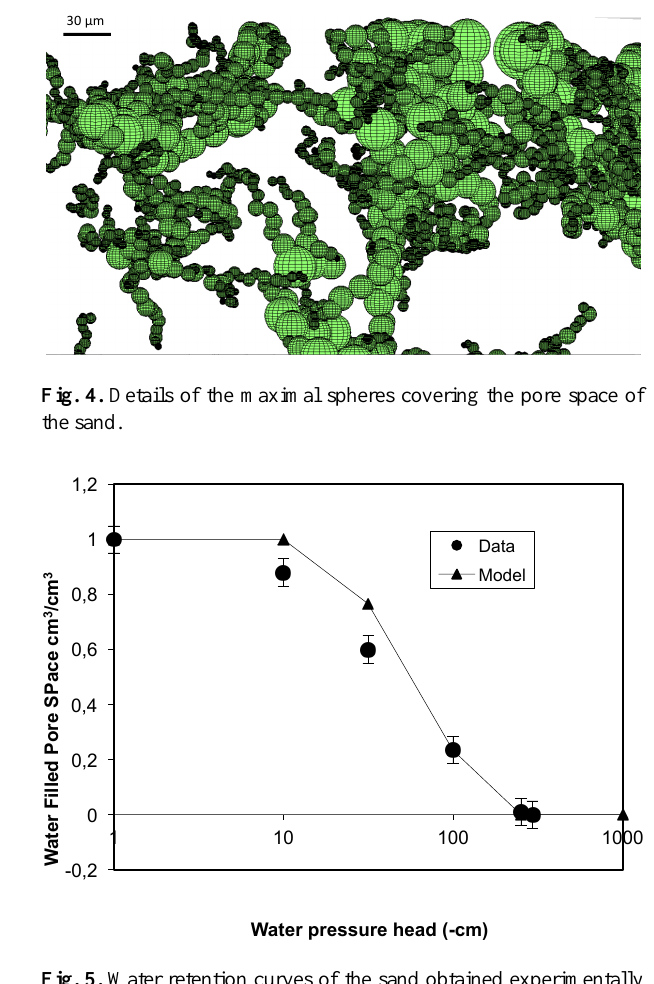
Fig. 5. Water retention curves of the sand obtained experimentally and with MOSAIC Figure 5: Water retention curves of the sand obtained experimentally and with MOSAIC II